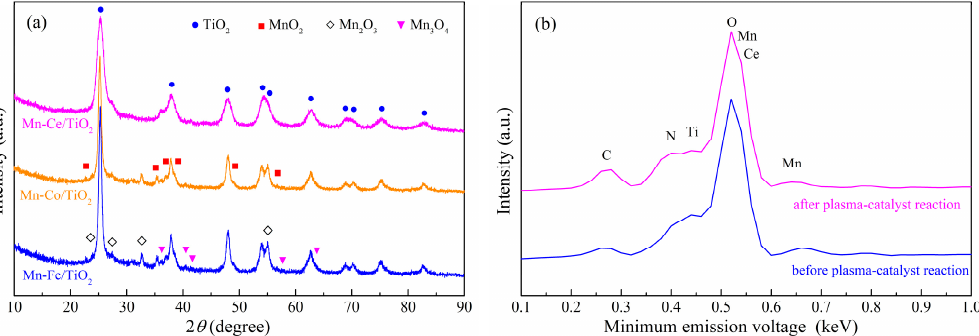
Figure 5. XRD patterns of Mn-based bimetallic nanocatalysts and element contents of Mn − Ce/TiO 2 before and after plasma-catalyst reaction. (a) XRD patterns of Mn − Ce/TiO 2 , Mn − Co/TiO 2 and 321 Mn − Fe/TiO 2 nanocatalysts; and (b) EDS patterns of element contents on the surface of Mn − Ce/TiO 2 . 322